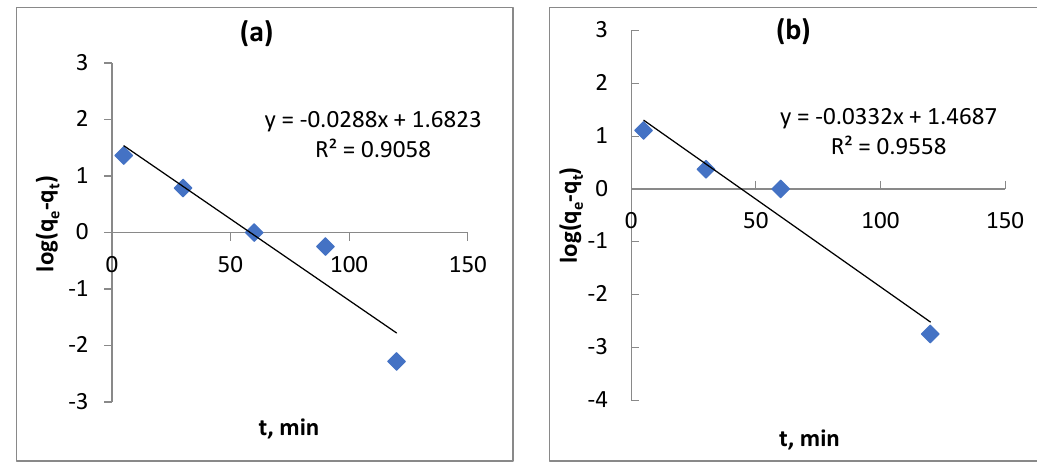
y = -0.0288x + 1.6823